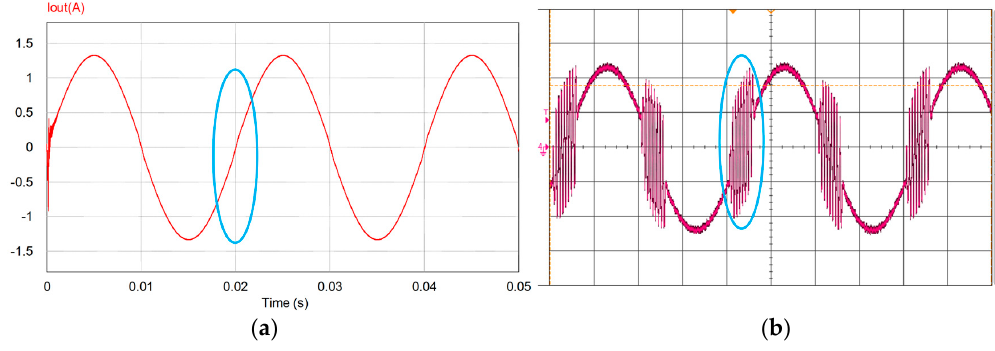
Figure 10. Simulation and Experiment results comparison: ( a ) simulation waveform before improving; and ( b ) experiment waveform.